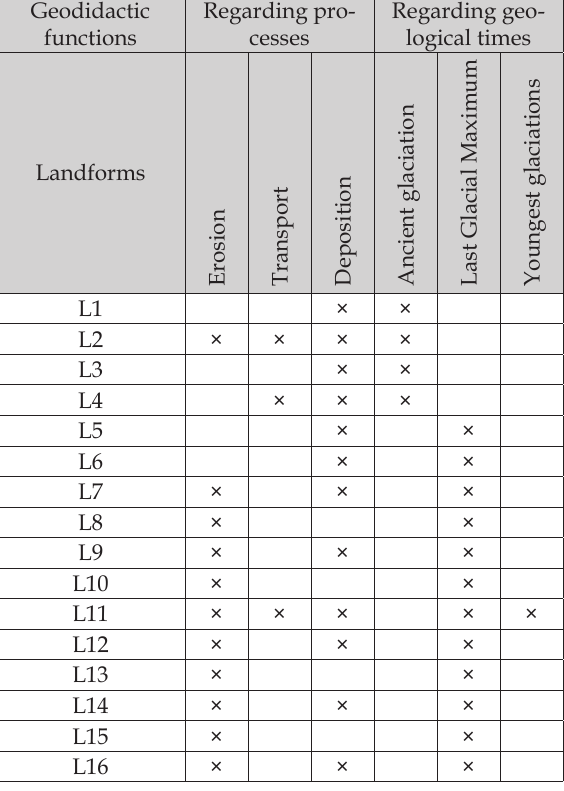
Table 2. Geodidactic functions of landforms regard- ing processes type and glacial